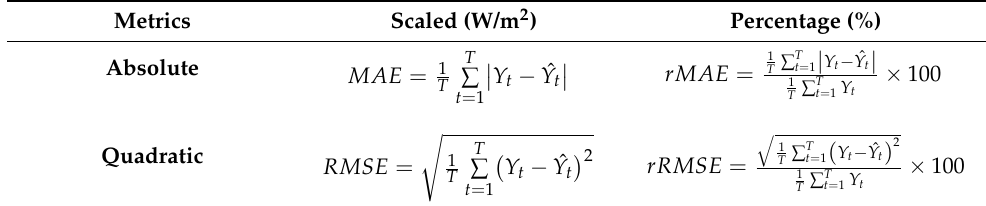
Table 2. Metrics used to evaluate the model performance.